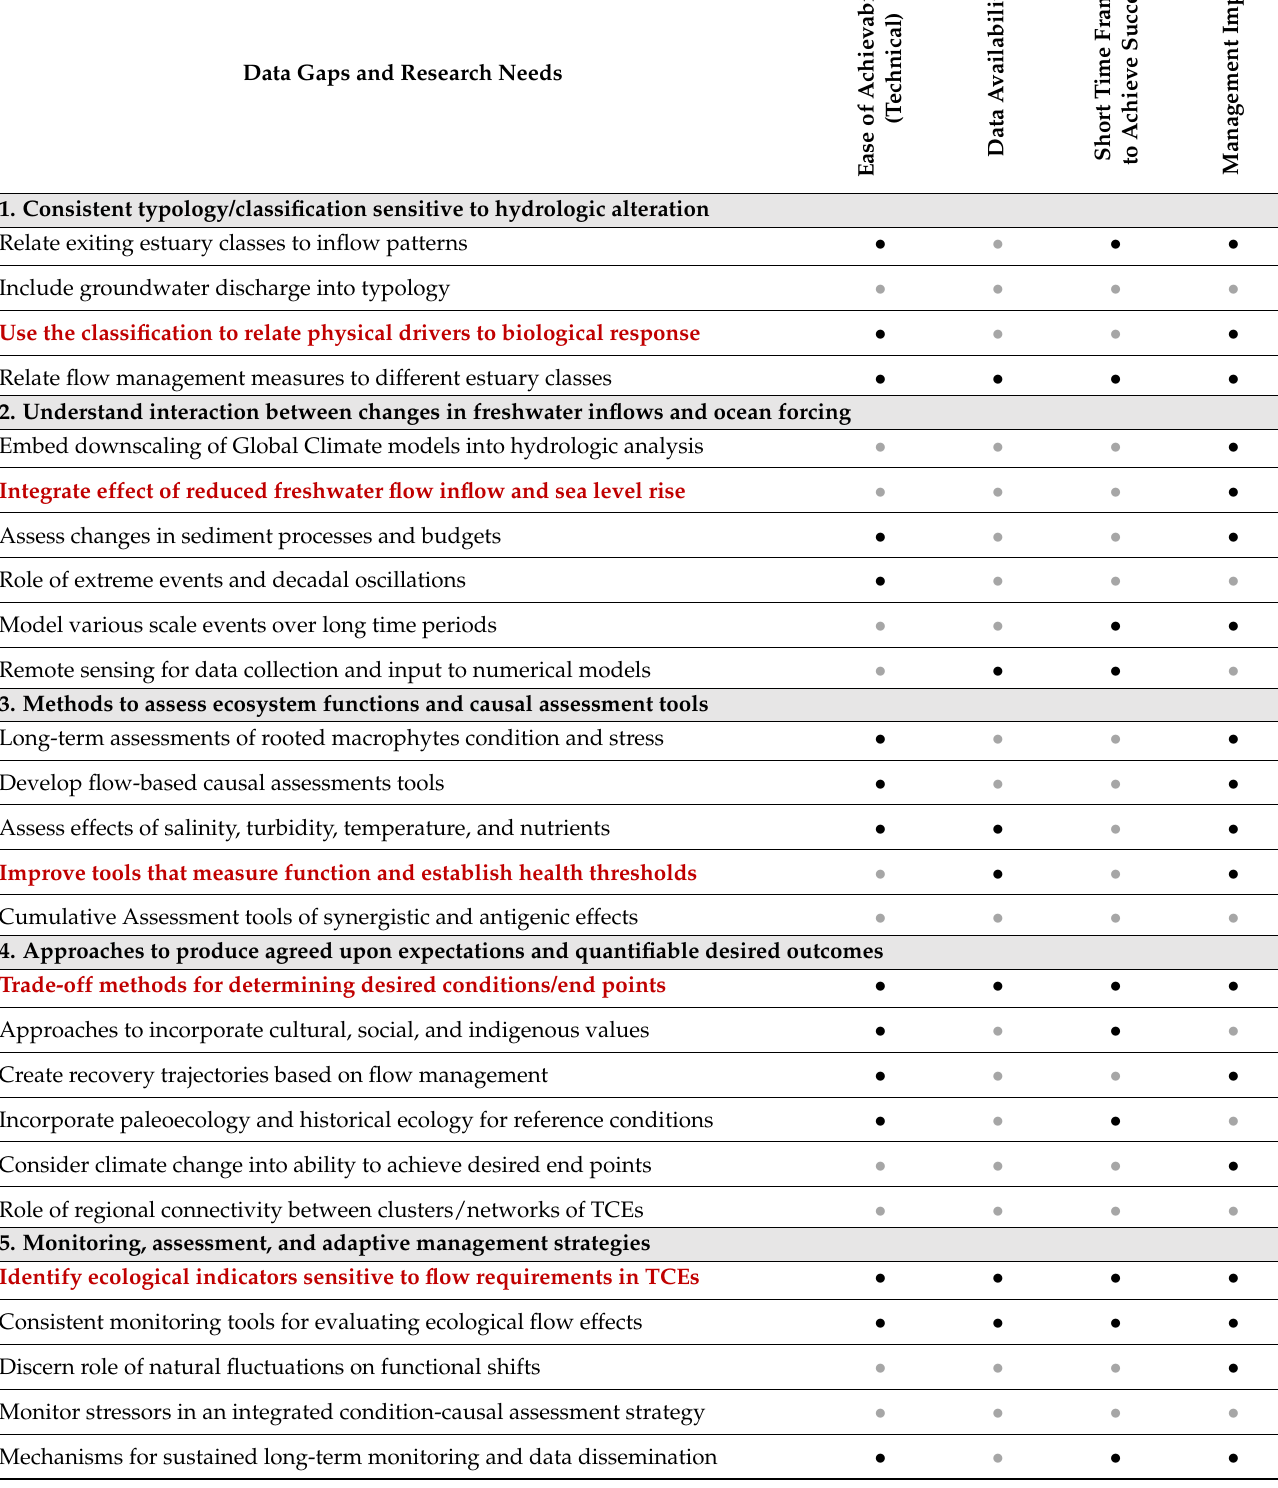
Table 2. Relative prioritization of identified research needs. Large black circles indicate relatively high ease of achieving, data availability, ability to accomplish in a short time frame, and high management impact. Small grey circles indicate relatively low levels for the same criteria. Red bolded text indicate highest priority needs for informing environmental flow management in